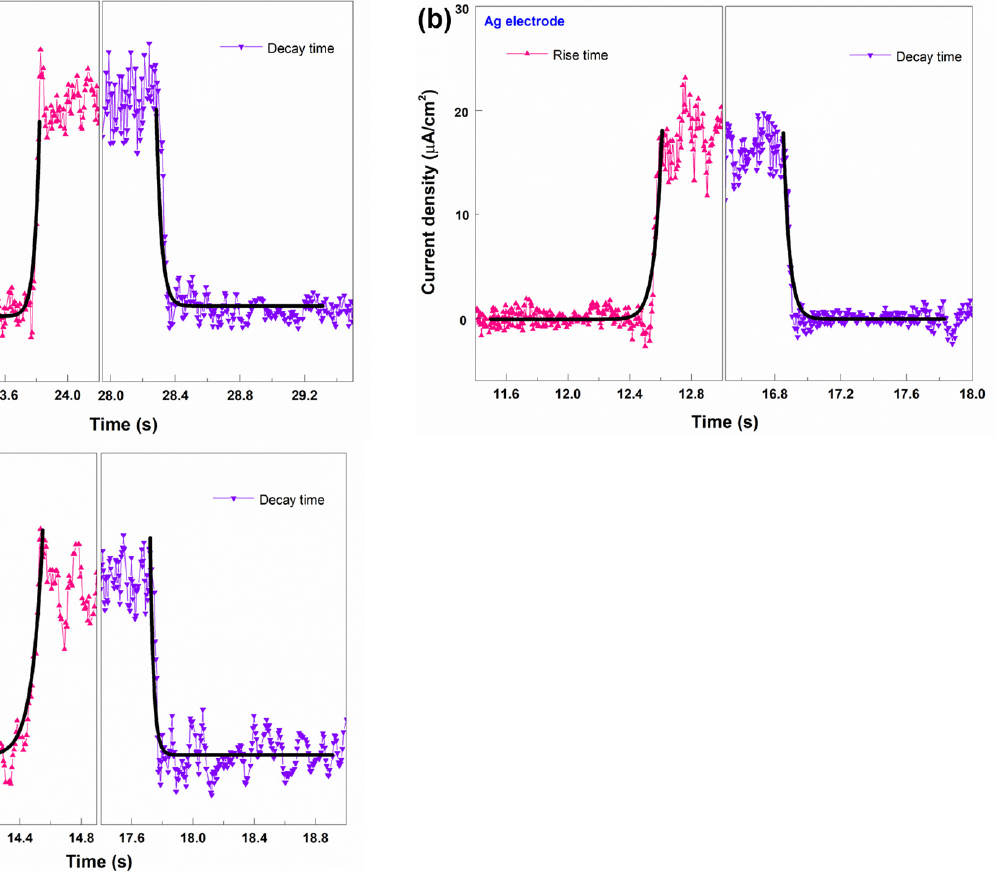
Figure 13. Rise time and decay time of time-dependent photocurrents of each photodetector irradiated with 1000 μ W/cm 2 UV light. ( a ) Ag:AZO 20 nm; ( b ) Ag 20 nm; ( c ) AZO 20 nm.